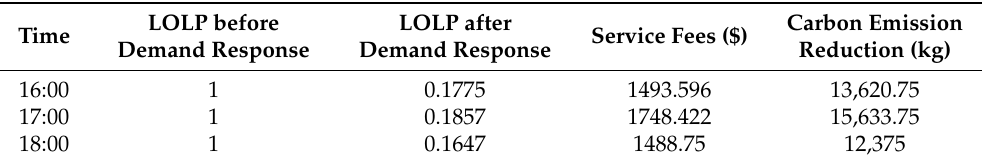
Table 5. Loss of energy probability.